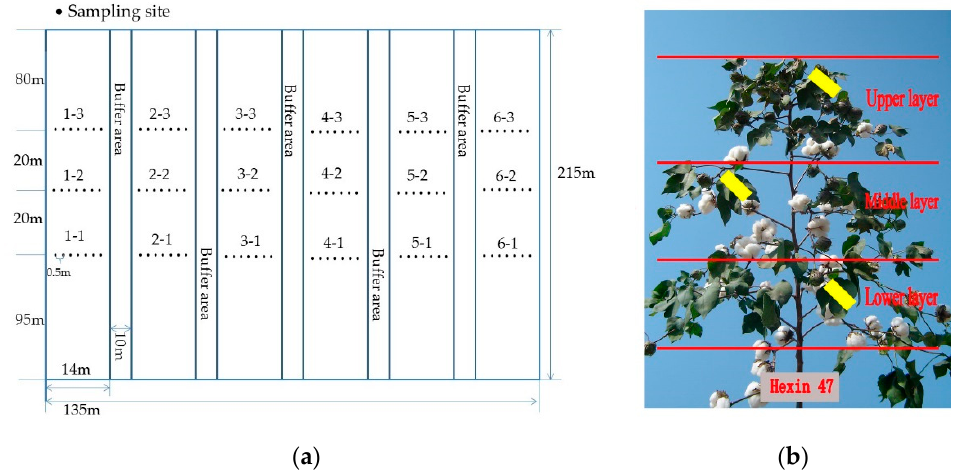
Figure 2. ( A ) Experimental layout of each treatment and ( B ) placement of water-sensitive paper at each sampling position within the cotton canopy.